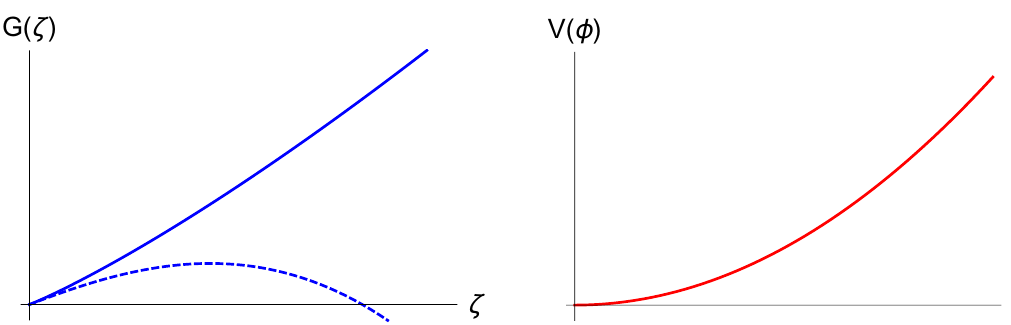
Figure 1. Reference plots of G ( ζ ) (left) and V ( φ ) = φ 2 (right) for F ( R ) = R + R n with n = 3 / 2 (continuous) and n = 5 / 2